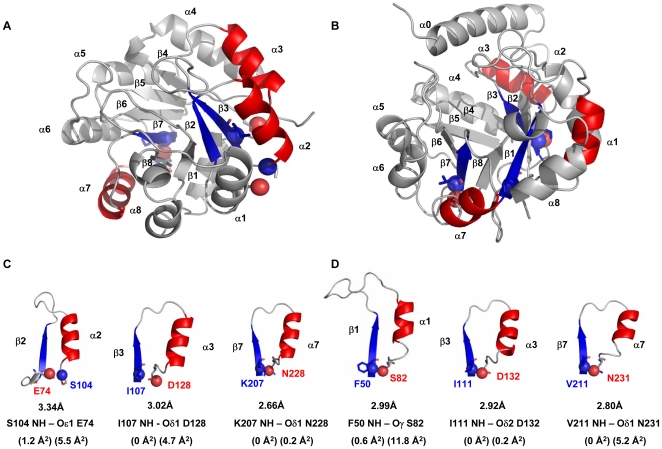
Ribbon diagrams of sIGPS (A) and eIGPS (B) highlighting the βα-hairpin clamps.(C) and (D) display the intervening elements of secondary structures between the residues forming the clamps for sIGPS: sIGPS-β2α2-S104NH→Oε1E74; sIGPS-β3α3-I107NH→Oδ1D128; and sIGPS-β7α7-K207NH→Oδ2N228 and for eIGPS: eIGPS-β1α1-F50NH→OγS82; eIGPS-β3α3-I111NH→Oδ2D132; and eIGPS-β7α7-V211NH→Oδ1N231. The SCs involved in the clamp interactions are highlighted with the H-bond donor and acceptor atoms shown in blue and red, respectively. The distances between the donor and acceptor atoms are indicated. The solvent exposed surface areas of the H-bond donor and acceptor atoms is shown in parenthesis. The H-bonds and their corresponding distances were determined by using the program HBPLUS [45]. The structures were generated using PyMOL v 0.99 [46], and the PDB codes are 2C3Z for sIGPS [21] and 1PII for eIGPS [22].